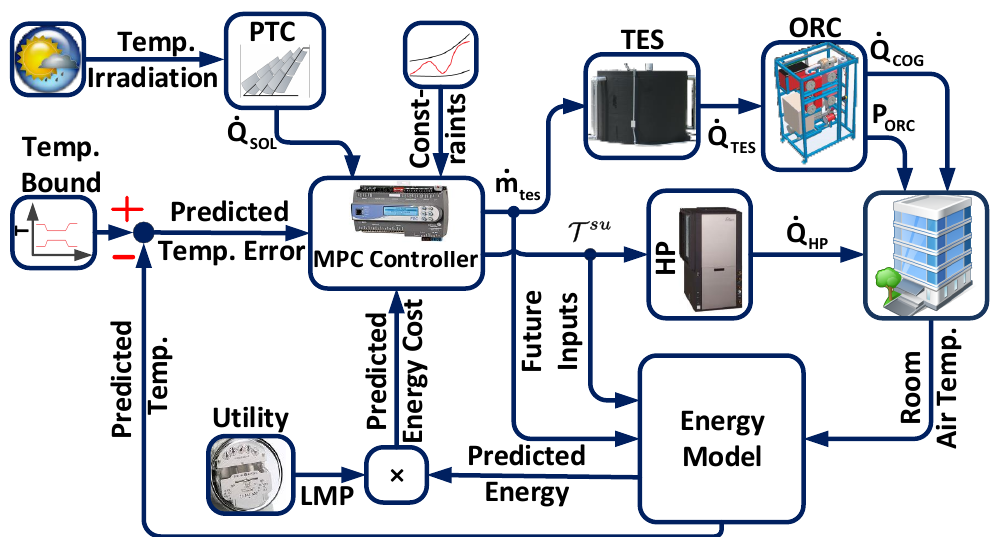
Figure 17. Structure of the MPC to minimize electrical energy cost. (Reprinted from [20] with permission of